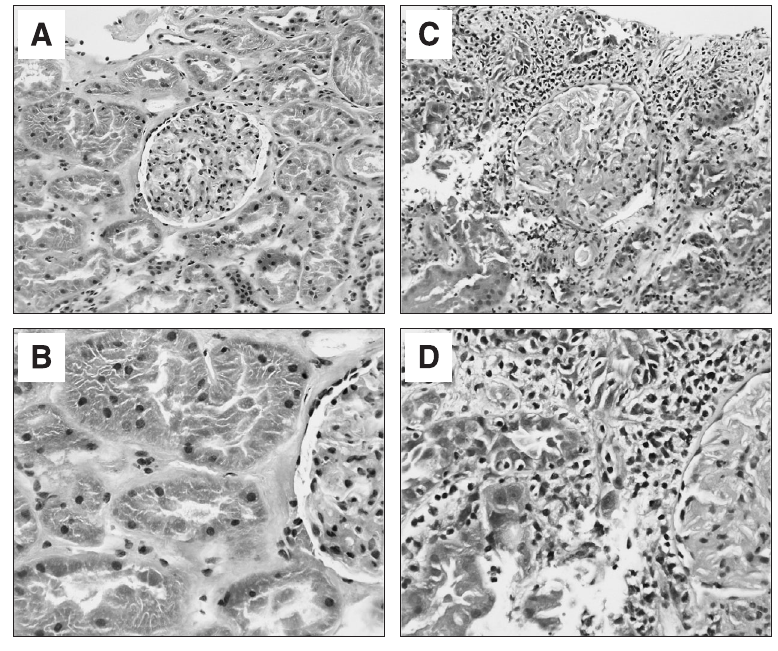
Figure 1. Inflammatory infiltrate in acute renal allograft rejection. A and B , A hematoxylin and eosin-stained renal allograft biopsy specimen obtained from a patient without rejection during a protocol biopsy. C and D , Intense interstitial inflammatory infiltrate characteristic of acute renal allograft rejection (Banff’ 97 grade IB). These inflammatory cells are the source of the inflammatory mediators (cytokines, chemokines, prostanoids) that orchestrate the alloimmune response. Top figures (A and C), 50X magnification; bottom figures (B and D) 100X